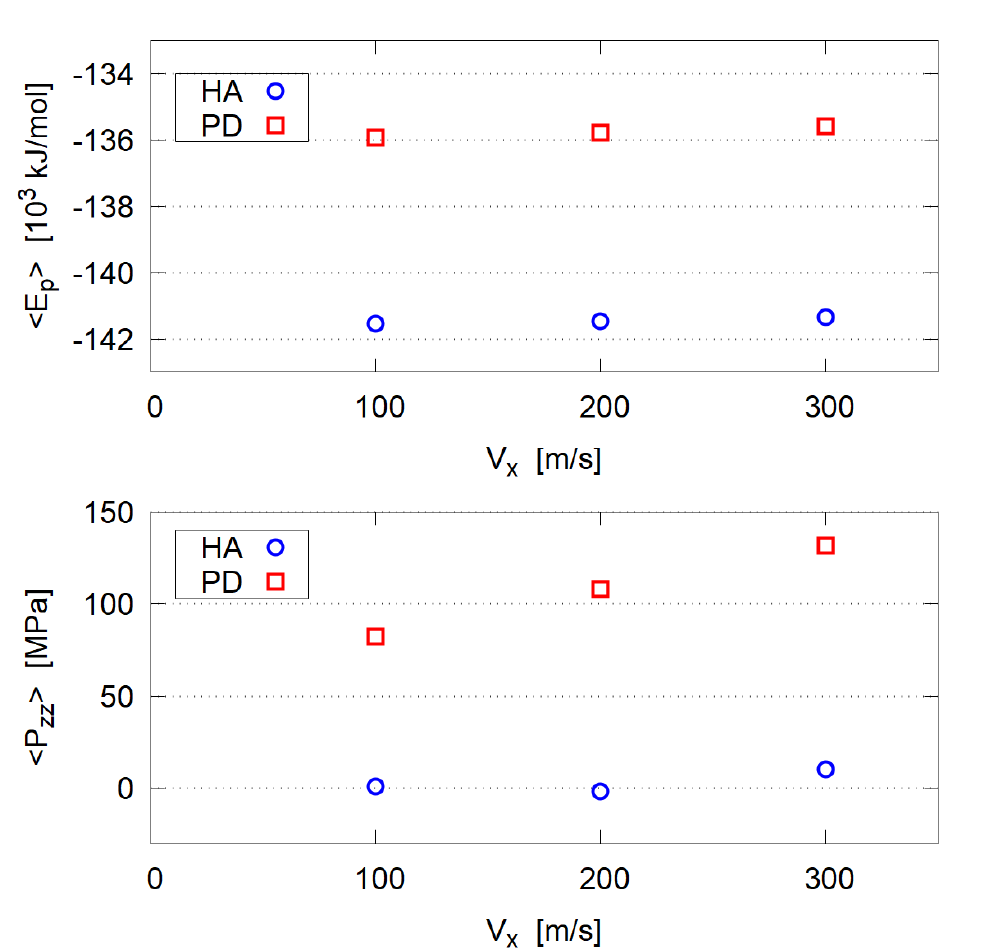
Figure 5. Averaged potential energy and pressure; the time average is taken for period 3ns ≤ t ≤